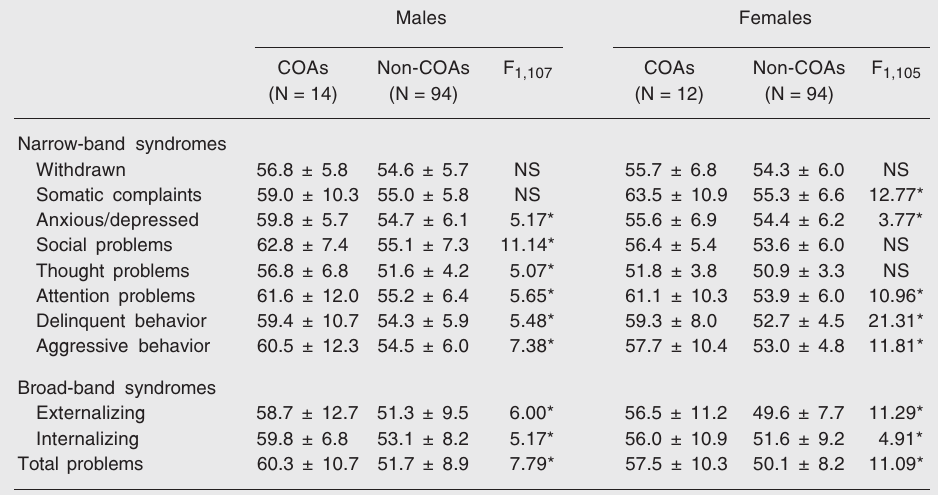
Table 3. Gender differences: Child Behavior Checklist ratings at 11